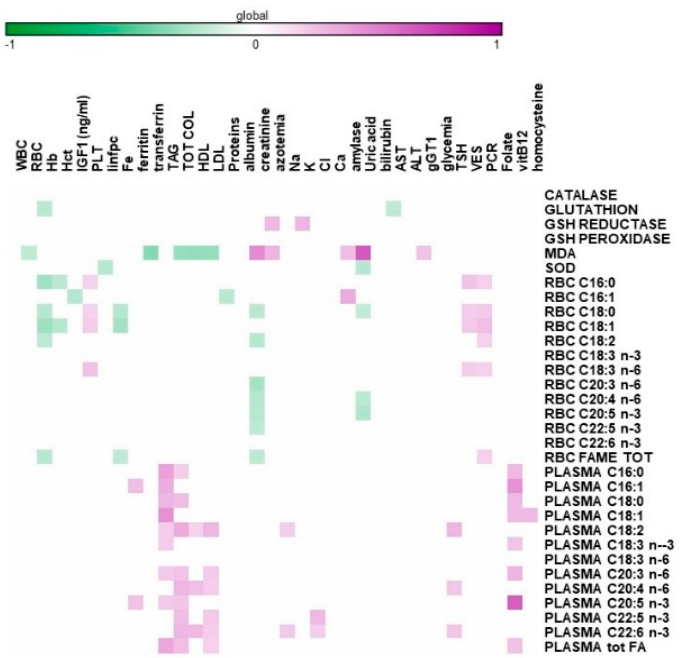
Figure 3. Heatmap reporting Pearson significant correlations ( p < 0.05) among sarcopenic elderly hematological measures versus the antioxidant system and lipidomic profile in plasma and red blood cells (RBC).